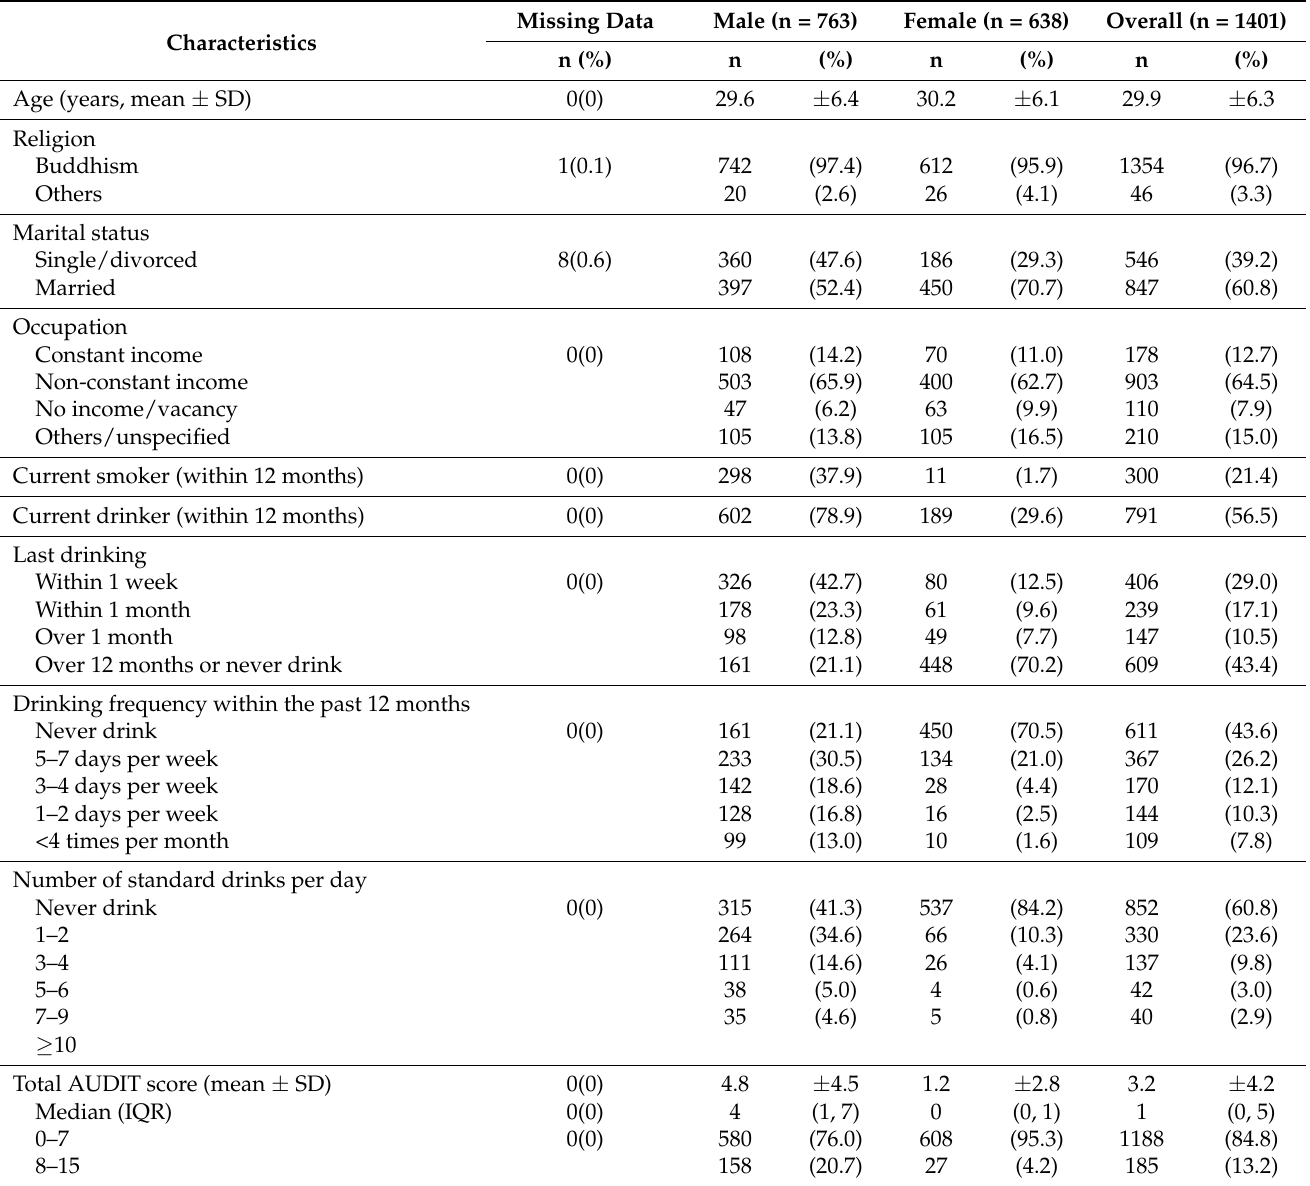
Table 1. Characteristics of study participants (n =